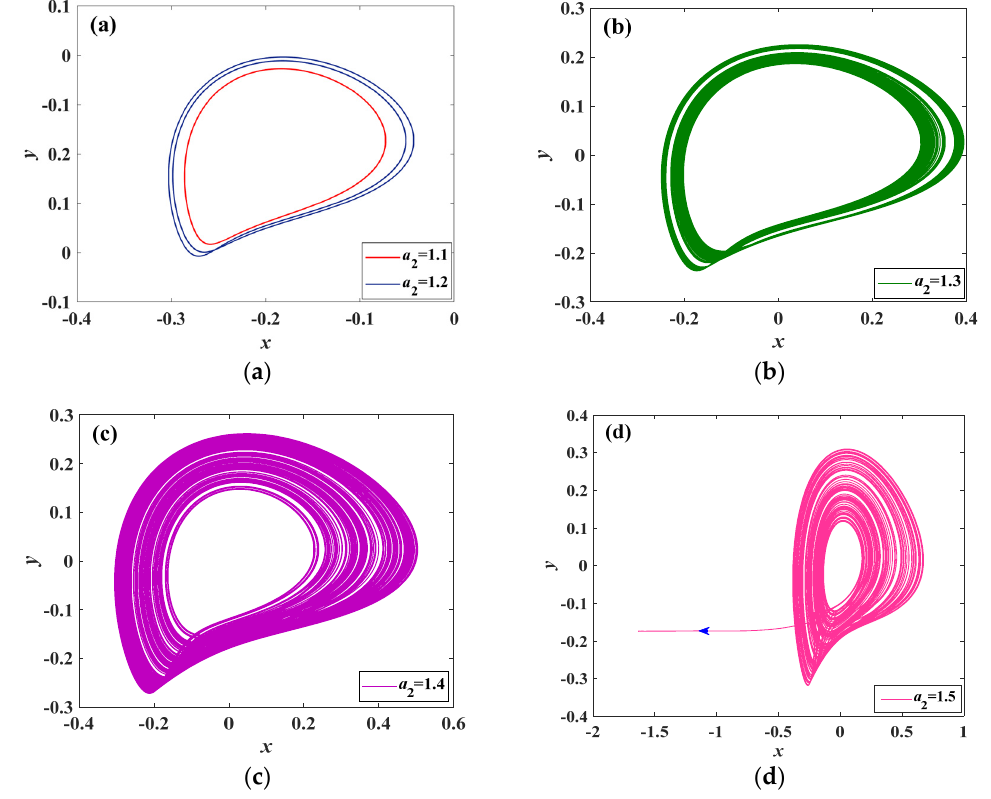
Figure 10. Phase portraits of the HNN under the parameter a 2 = 1.1, 1.2, 1.3, 1.4, 1.5: ( a ) a 2 = 1.1, 1.2; ( b ) a 2 = 1.3; ( c ) a 2 = 1.4; ( d ) a 2 = 1.5.